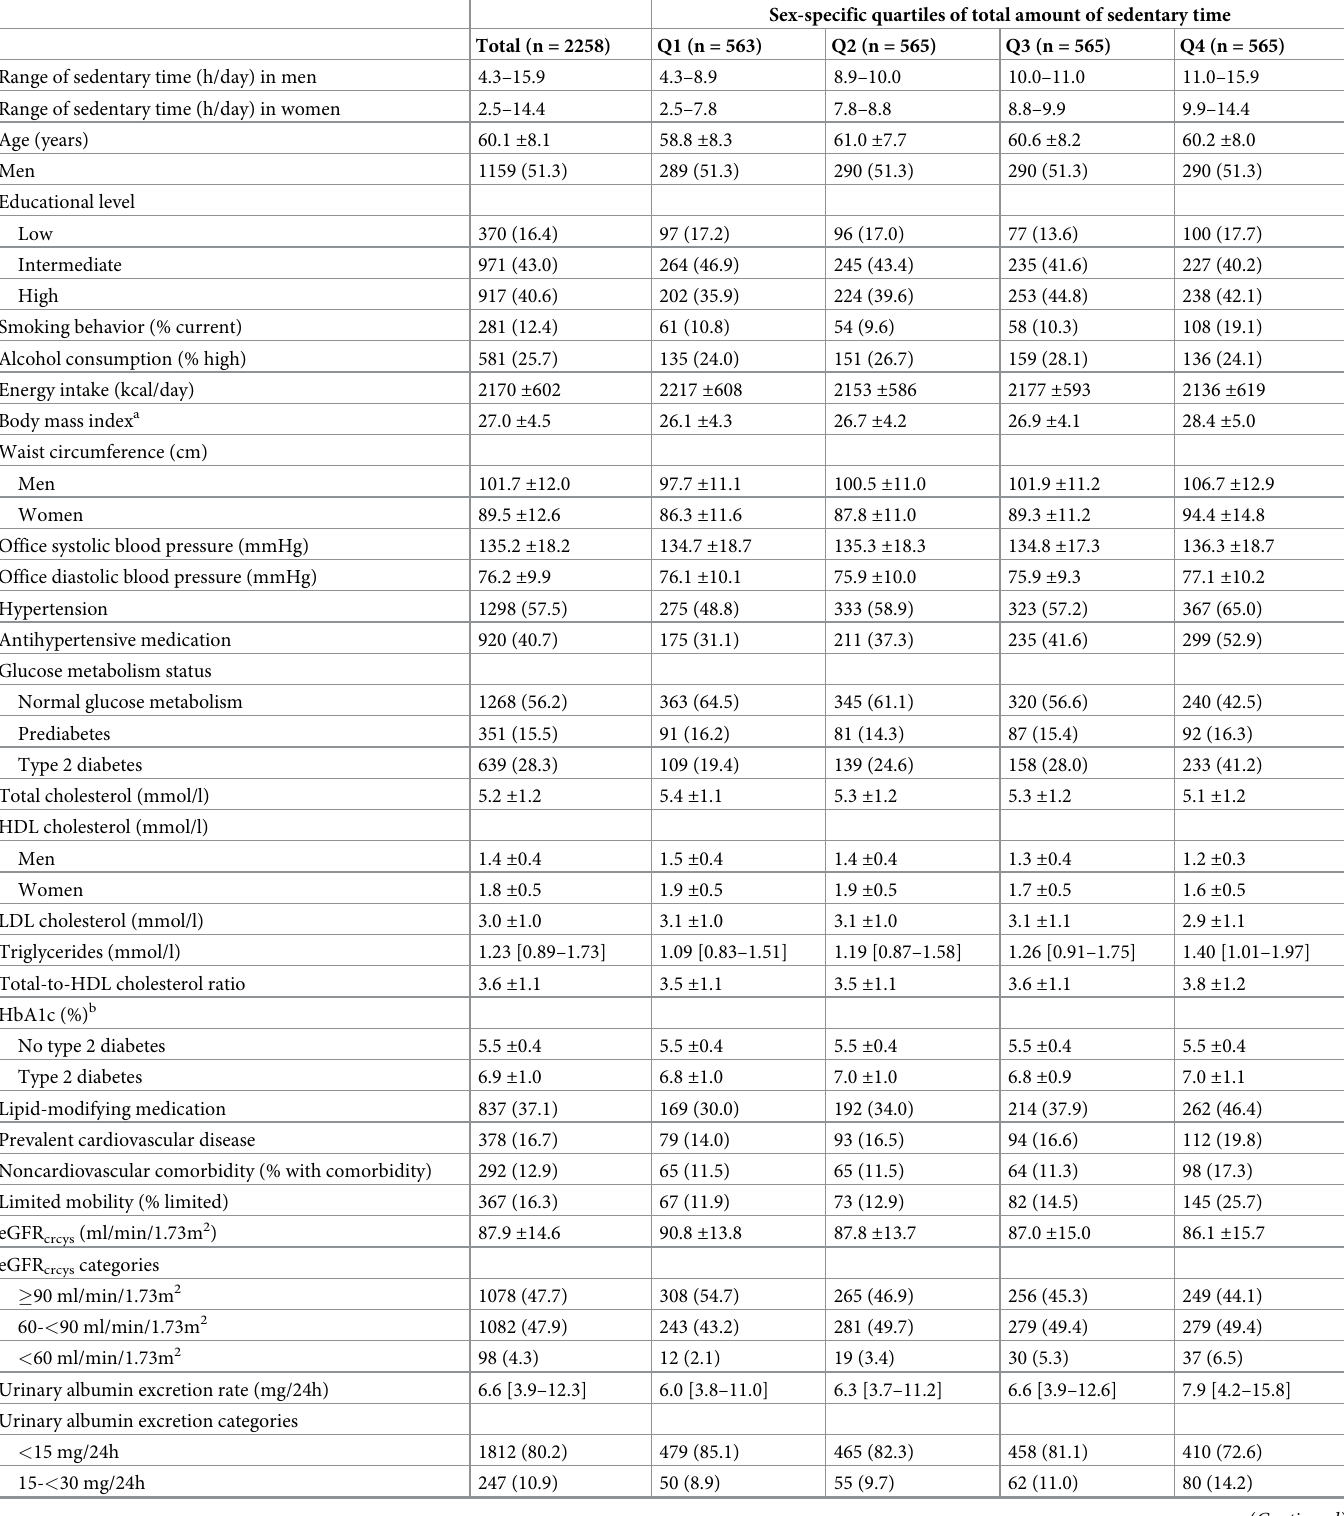
Table 1. Characteristics of the total study population and stratified according to quartiles of total amount of sedentary